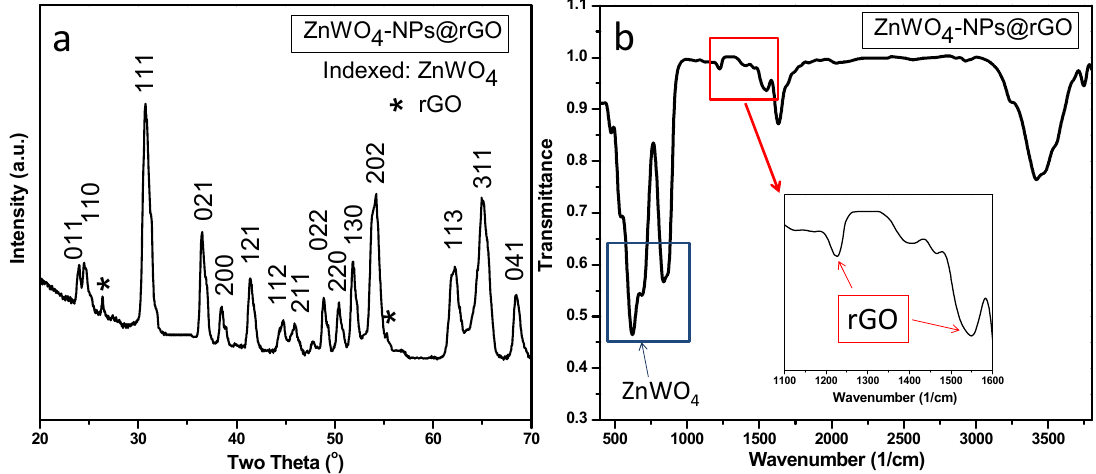
Figure 1. ( a ) XRD patterns and ( b ) FTIR spectrum of synthesized ZnWO 4 -NPs@rGO nanocomposites.